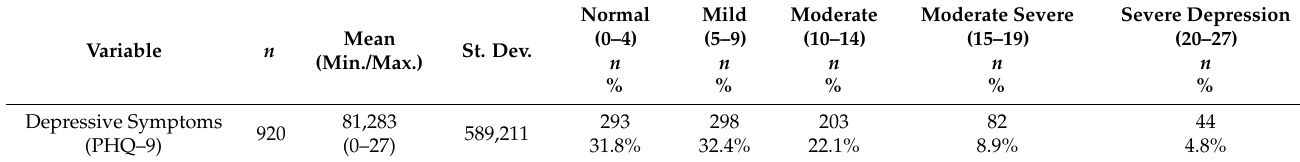
Table 1. Depressive symptoms distribution.